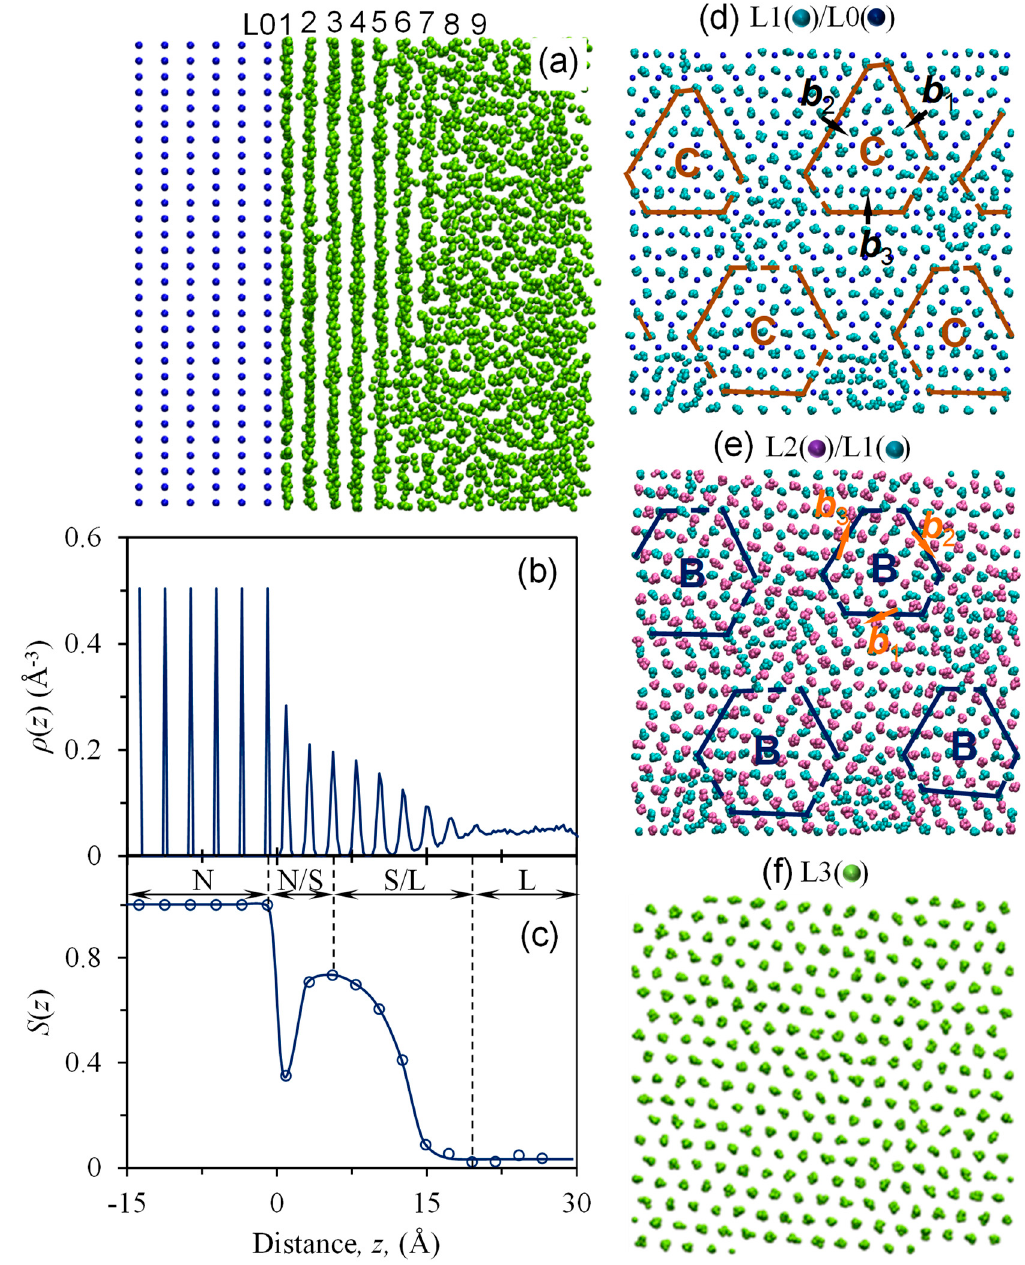
Figure 6. ( a ) A snapshot, and ( b ) ρ ( z ), and ( c ) S ( z ) as a function of z from the interface at t = 50 ps during the simulation for the system with f = − 8% at T n = 760 K. Time-averaged atomic positions of ( d ) L1 on top of L0 showing the partial edge dislocation network; ( e ) L2 on top of L1 showing the partial screw dislocation network; and ( f ) L3 showing a nearly perfect plane of the solid that templates further growth. The b 1 , b 2 , b 3 ( b ′ 1 , b ′ 2 , b ′ 3 ) and the arrows represent the Burges vectors of the Shockley partial edge (screw) dislocations in the L1 (L2).